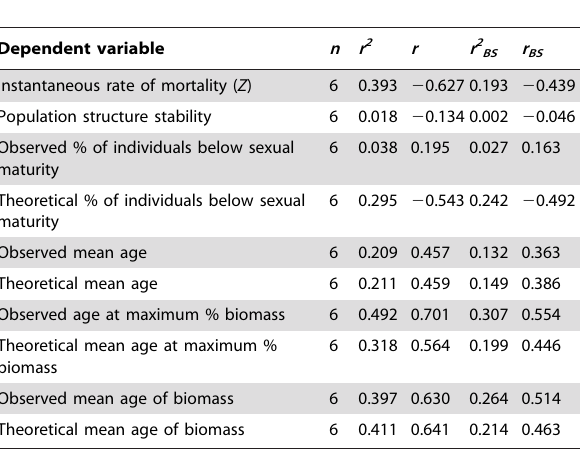
Table 2. Correlation analyses between sea surface temperature (independent variable) and demographic parameters (dependent variables) in the sampled